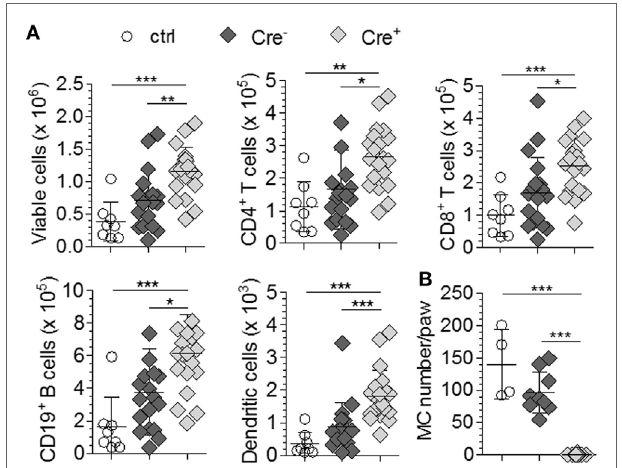
FigUre 1 | Hypertrophy of LNs draining E. coli -infected tissue does not depend on mast cells (MCs). (a) Total LN cellularity and absolute size of different cell populations of the ipsilateral popliteal LN analyzed 24 h after injection of 1 × 10 5 E. coli J96 into the hind footpad of Cre -negative R26 DTA/DTA ( n = 9) and Mcpt5-Cre + R26 DTA/DTA mice ( n = 10). Four Cre -negative control mice were injected with saline. Data from two independent experiments with similar results. Means ± SD are shown. (B) Numbers of MCs in E. coli J96-infected or saline-injected footpad tissue of the animals in (a) 24 h after infection as determined by histological analysis of Giemsa-stained tissue sections. Means ± SD are shown. In all cases, statistical analysis was performed using one-way ANOVA and Bonferroni’s multiple comparison